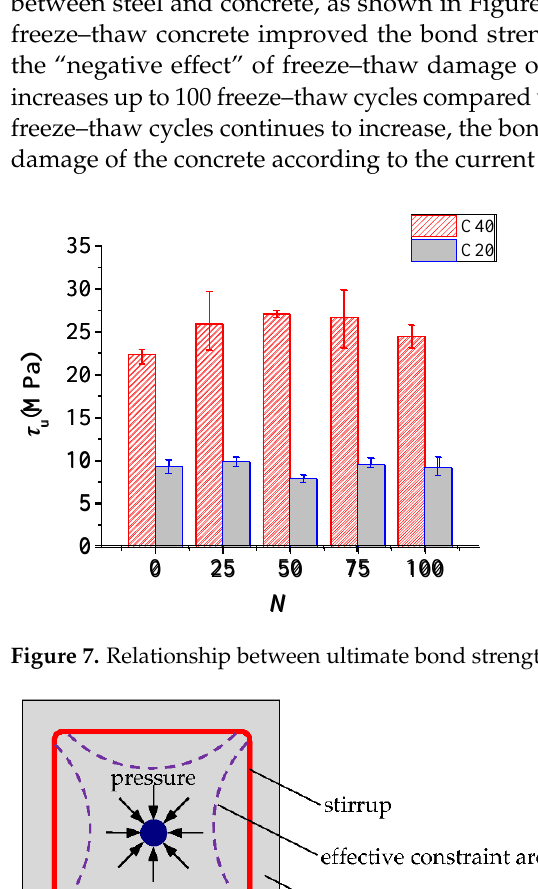
Figure 6. Concrete strengthunder different freeze–thaw cycles N . ( a ) Compressive strength; ( b ) splitting tensile strength.